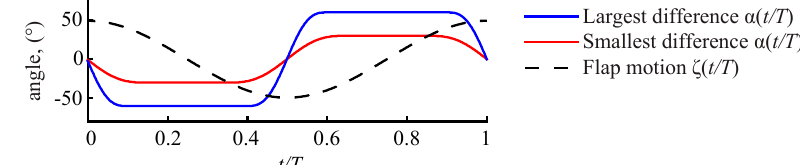
Figure 13. Plots of wing pitching and flapping for the smallest difference motion versus the largest difference motion. The largest difference motion is characterized by A = 60°, Z = 49.3°, Δ τ r = 0.2, and x pa = 1.0. The smallest difference motion is characterized by A = 30°, Z = 49.3°, Δ τ r = 0.3, and x pa = 0.5.